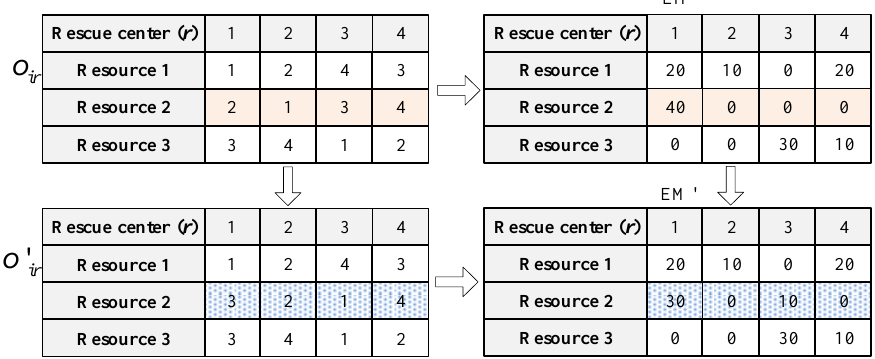
1111 rs k Figure 5. Illustration of crossover for sub-chromosome k. 3.2.4 Mutation Operator For sub-chromosome EM, the mutation operation is carried out by regenerating the